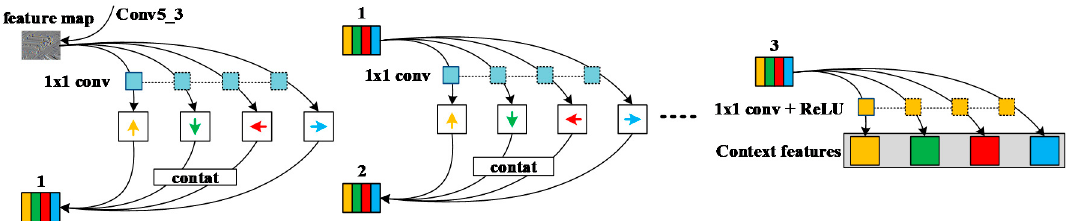
Figure 3. Feature extraction model based on contextual information.